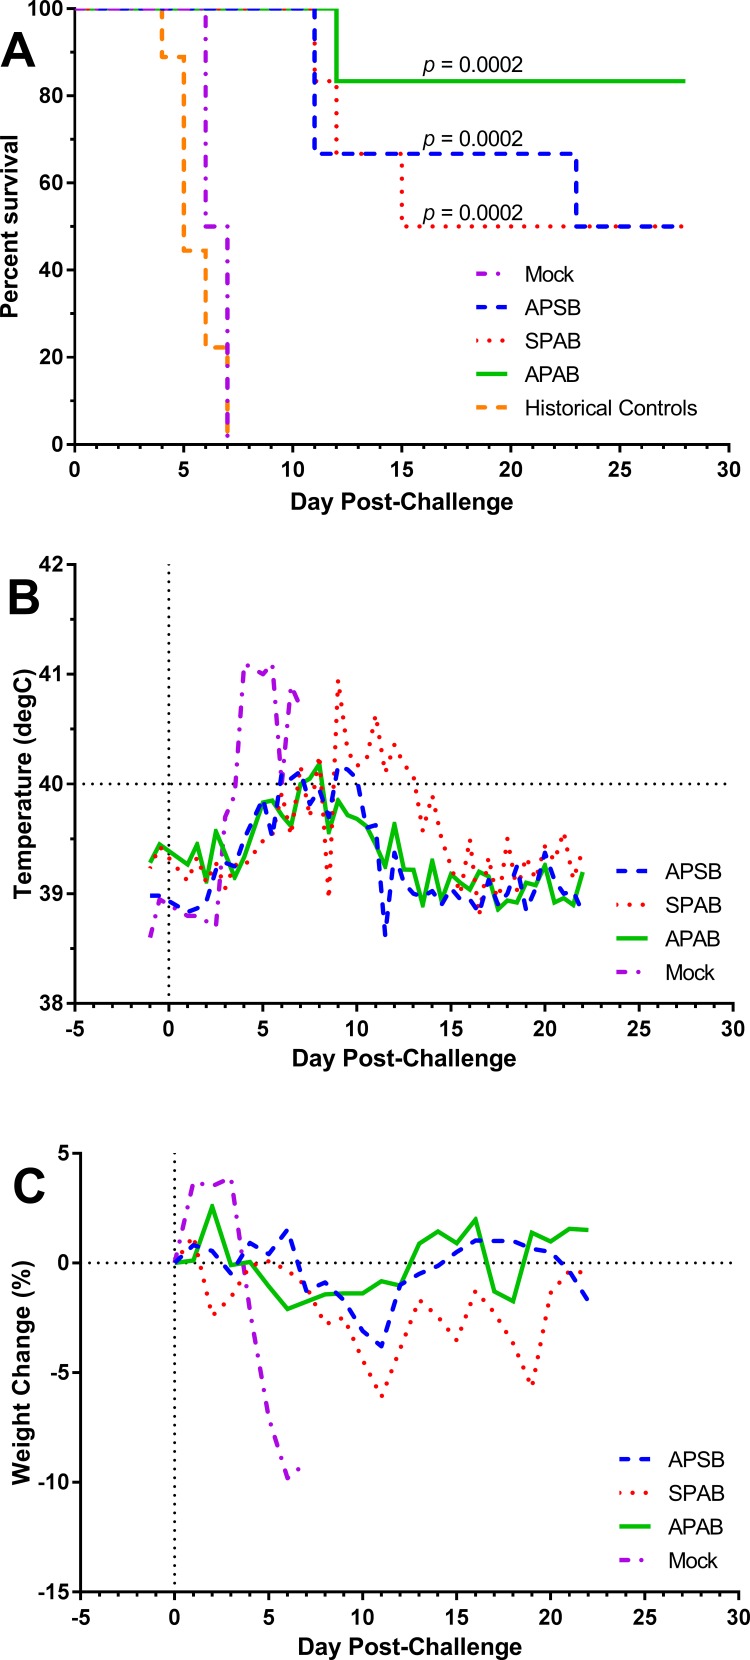
Prime and boost vaccination with S4ΔaroD provides strong protection against aerosol challenge with SCHU S4.Rabbits were vaccinated with a prime and boost of S4ΔaroD by aerosol or scarification prior to aerosol challenge with a median dose of 248 cfu SCHU S4 (range: 77–994 cfu). Thirty days post-boost, the rabbits were challenged with SCHU S4. Survival was tracked for 28 days post-challenge; body temperature and weight were tracked until day 22, when surviving rabbits had returned to baseline values. Mock = mock vaccinated controls (n = 2); APSB = aerosol prime, scarification boost (n = 6); SPAB = scarification prime, aerosol boost (n = 6); APAB = aerosol prime, aerosol boost (n = 6). Historical naïve or mock-vaccinated controls given equivalent challenge doses are also shown (n = 9). A) Percent survival in each group after aerosol challenge with 248 cfu SCHU S4. Kaplan Meier analysis indicated survival of all three vaccine groups was significantly better than mock-vaccinated rabbits (including historical controls). APAB: 83% survival, p = 0.0002; SPAB: 50% survival, p = 0.0002; APSB: 50% survival, p = 0.0002. B) Mean fever response to aerosol challenge with SCHU S4. C) Mean weight loss after aerosol challenge with SCHU S4.